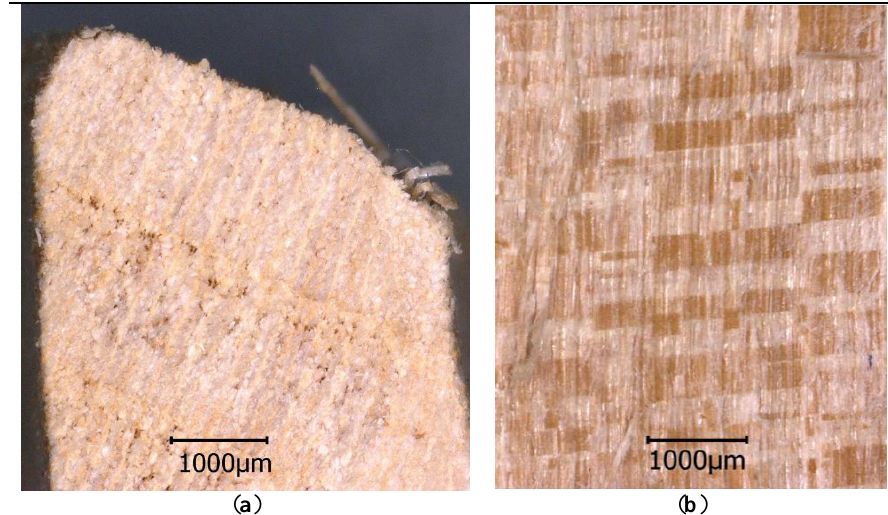
Figure 5. The fracture pattern in semi-ring-porous and diffuse-porous hardwoods: ( a ) the cross section of the Wild cherry, the fracture along a growth ring border; ( b ) the radial fracture section of the Alder, the fracture along the rays.